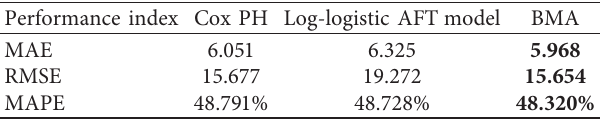
Table 5: A comparison of some posterior effect probabilities from BMA and p values from the Cox PH